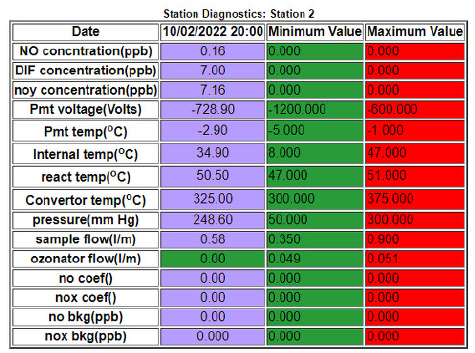
Figure 11. Operating parameters for selected analyzer.